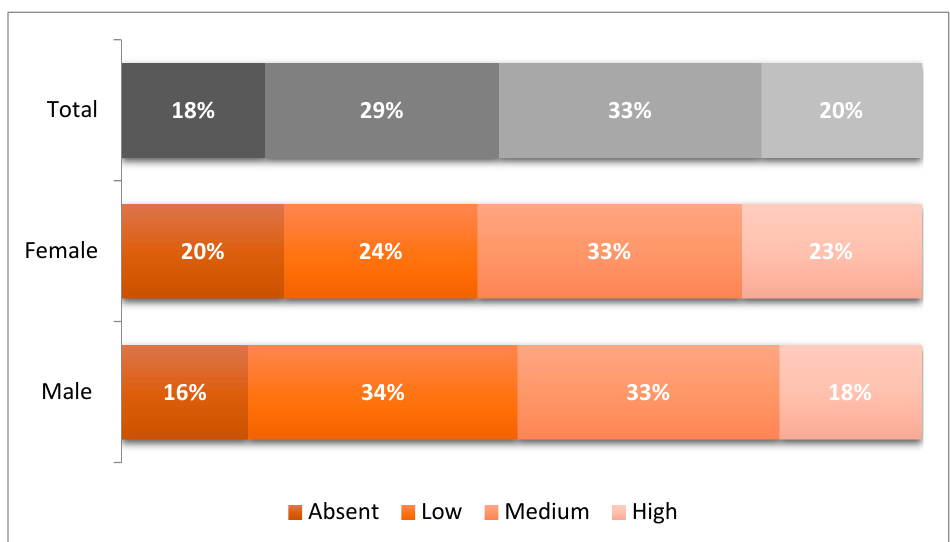
Figure 2. Levels of adherence to female gender roles (% by sex).